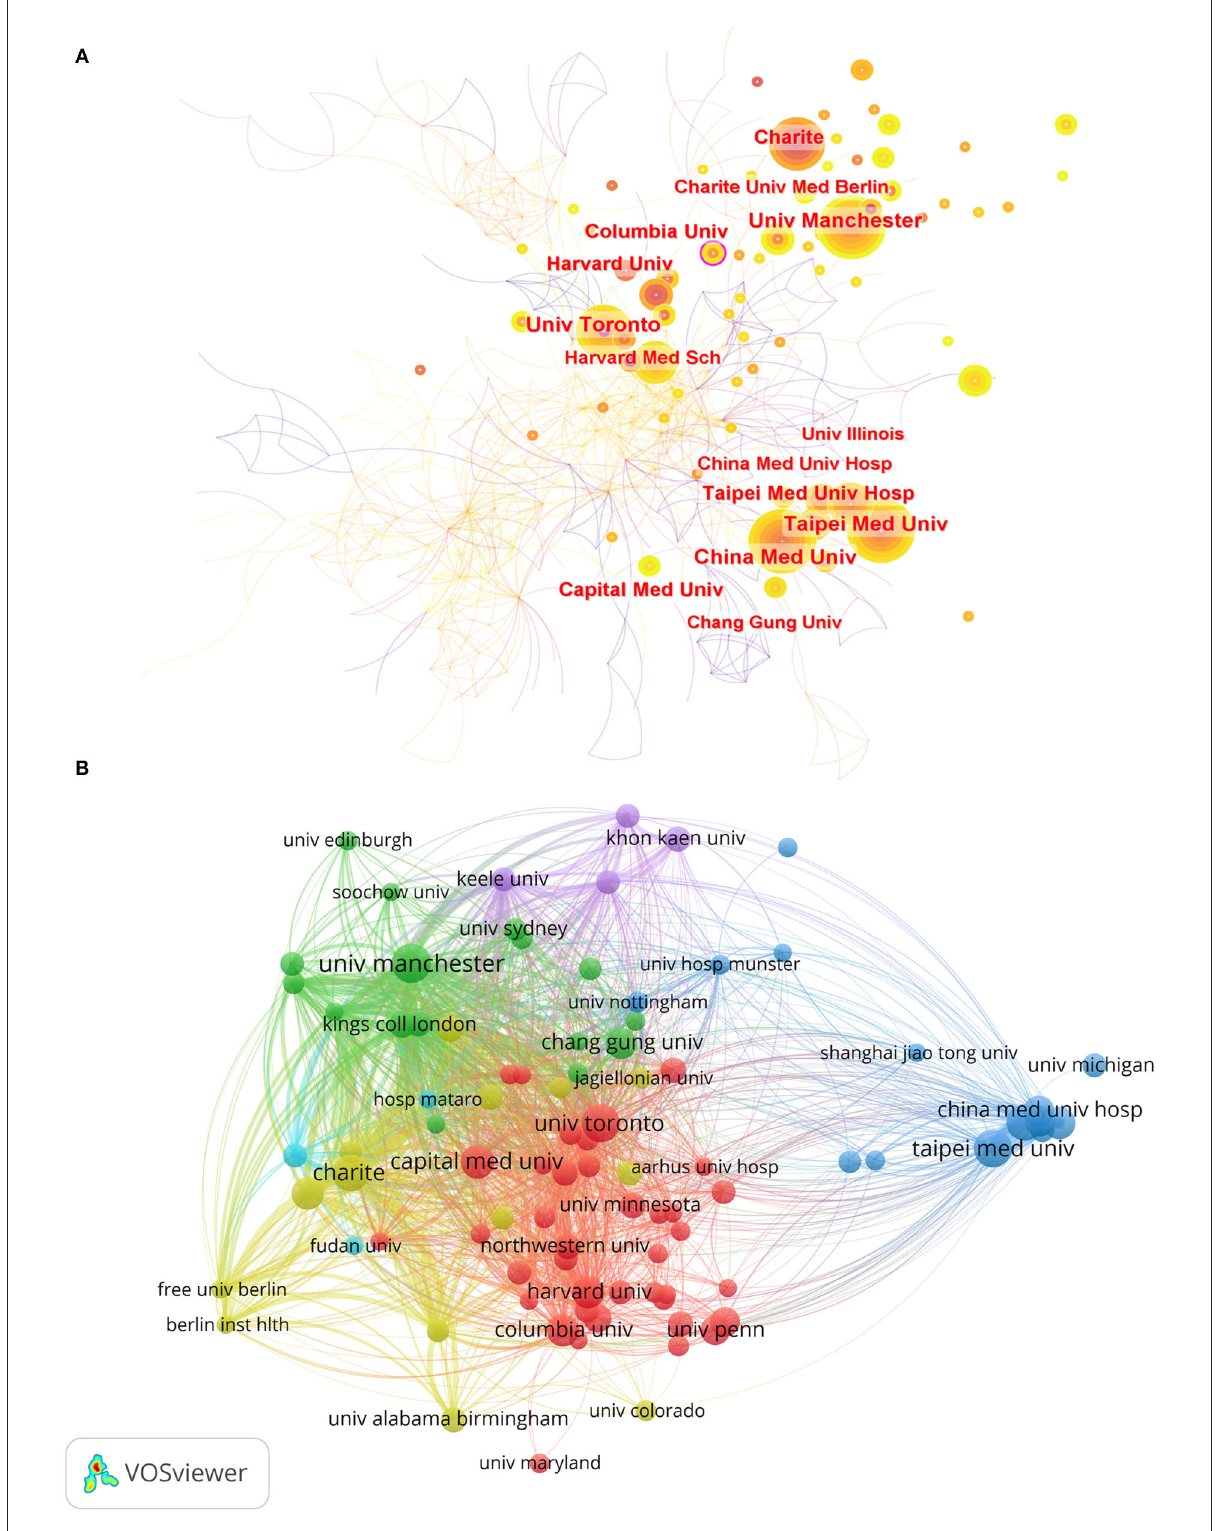
FIGURE4 (A) The network cooperation map of institutions involved in post-stroke pneumonia research by using CiteSpace. (B) The institution’s citation network visualization map created with VOS